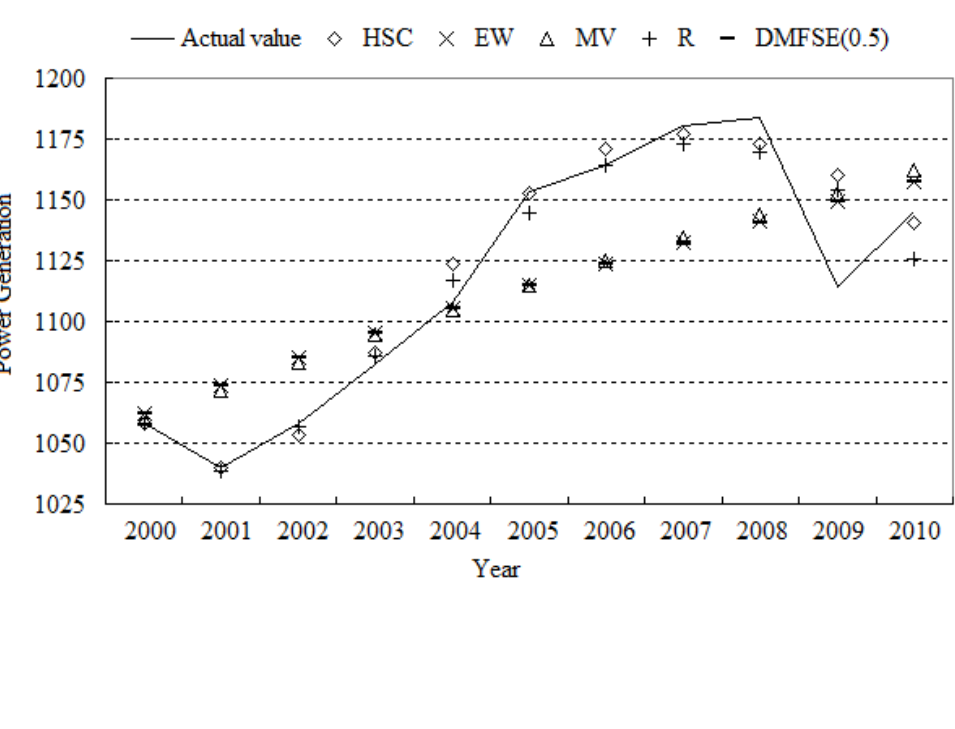
Figure 7. Forecasting performance of HS based JPOC model and other combination models for